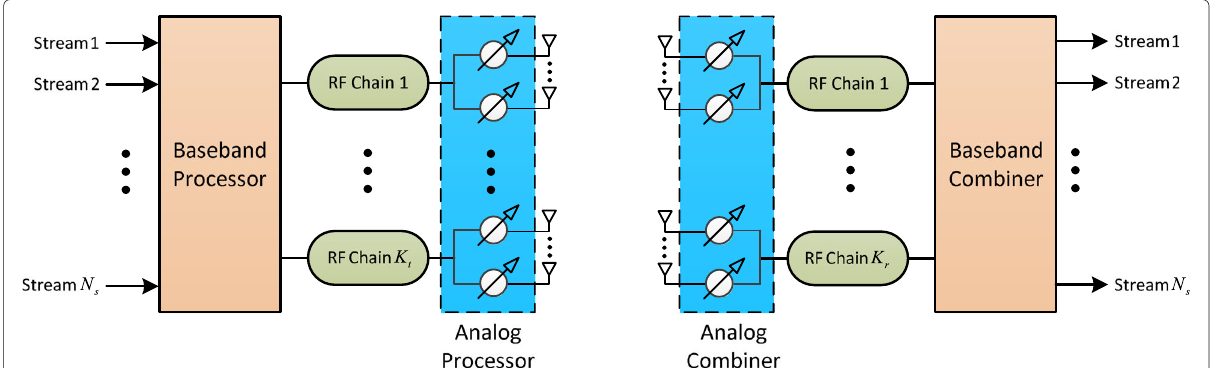
Fig. 3 Block diagram of a mmWave massive MIMO system with the conventional partially connected RF